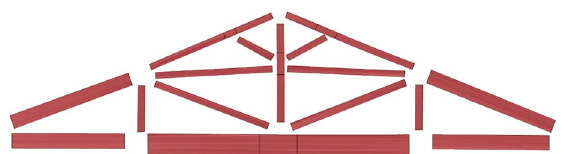
Figure 6: From cross-sections to creation of elements of the truss through the “loft” command